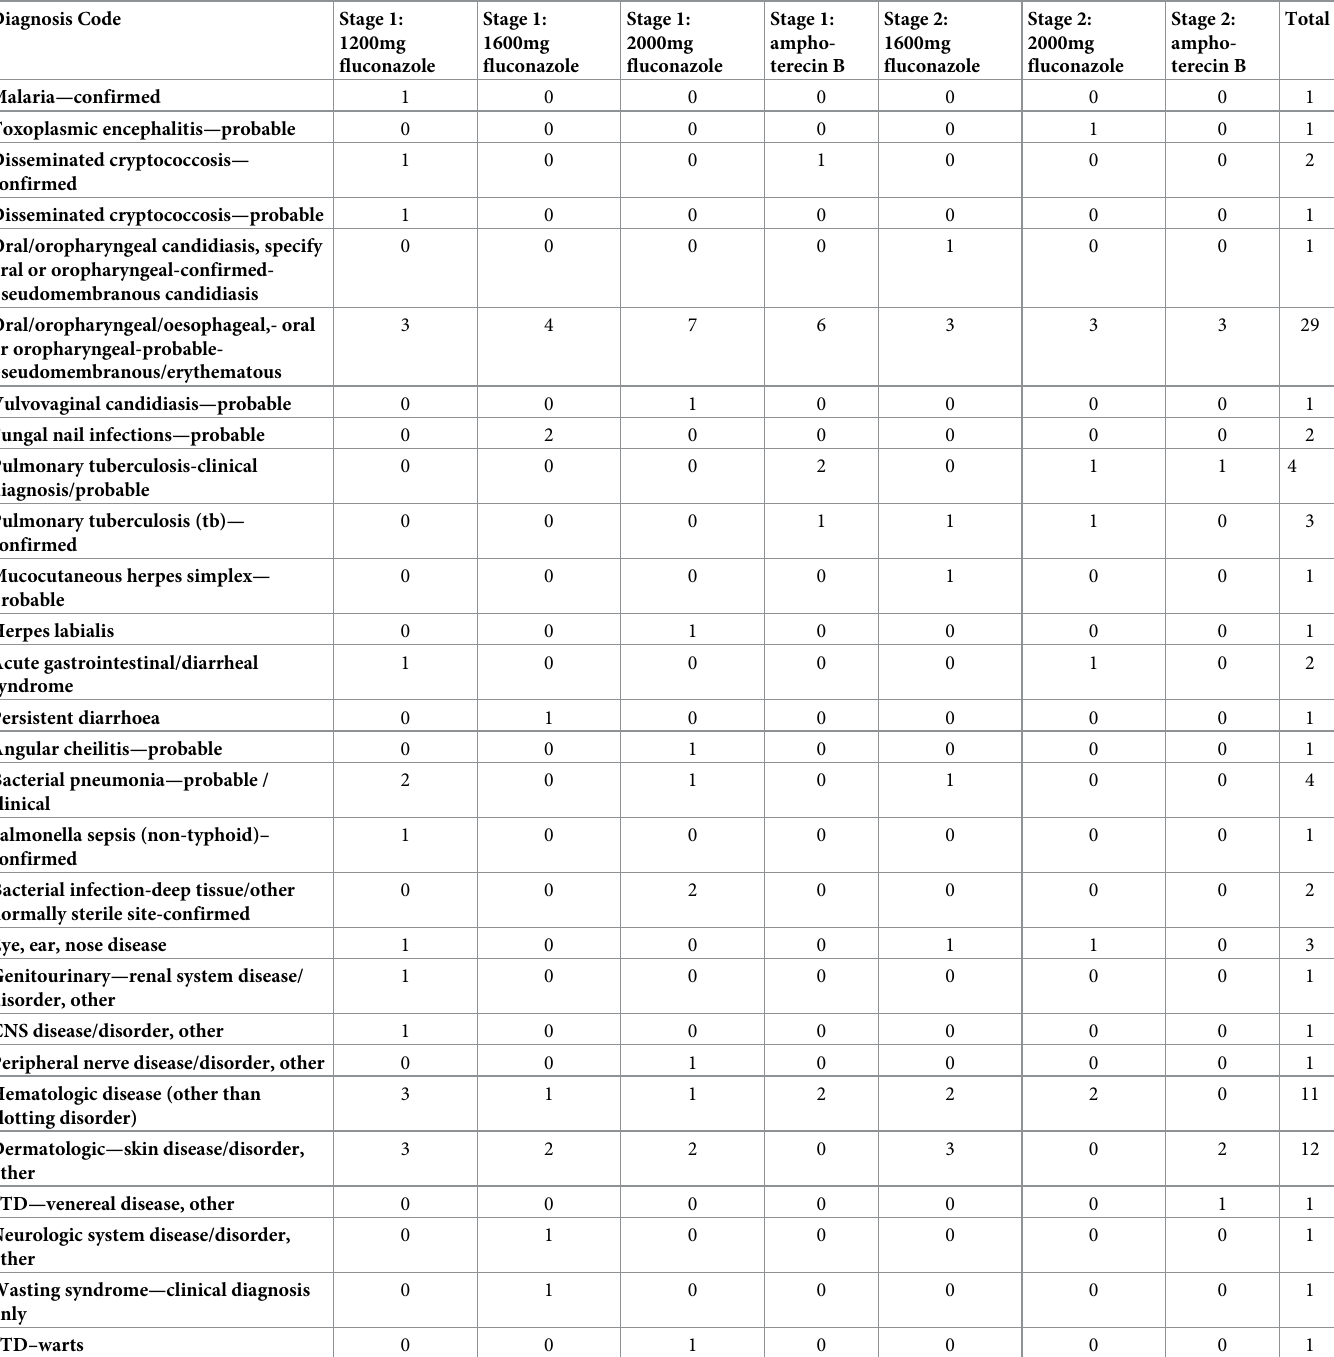
Table 3. Baseline non-cryptococcal meningitis opportunistic infections and AIDS-defining conditions by Stage and